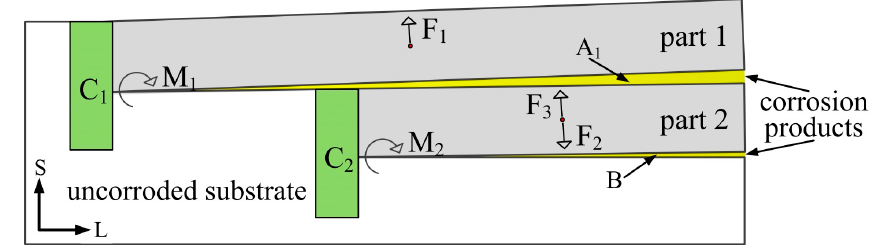
15 of 18 Figure 13. S-L sectional analysis in the junction area between the corroded and un-corroded substrate of the specimen exposed for 20 years: ( a ) SEM morphology; ( b ) local enlarged SEM morphology; ( c ) EDS spectrum in the lump area of the corrosion products; ( d ) EDS spectrum in the cracking area of the corrosion products. The analysis of wedge exfoliation that occurred near the A area in Figure 13b can be simplified into the mechanical model shown in Figure 14. Under the action of the expansion force of the corrosion product in the A 1 area, structures of aluminum alloy on the upper side (part 1) exfoliated outwardly, and the intergranular corrosion of structures under the lower side (part 2) also occurred along the L direction. Compared to the area of un-corroded substrate, the exfoliation of the structures on both the upper and lower sides of the A 1 area can be considered as the bending of the cantilever beam under load. For the equilibrium of part 1, the wedging force of corrosion products, F 1 , and the bending moment, M 1 , produced at the cantilever beam base, C 1 , must be in balance. Similarly, for the equilibrium of part 2, the wedging forces of corrosion products, F 2 and F 3 , and the bending moment, M 1 , produced at the cantilever beam base, C 2 , must be in balance. It was obvious